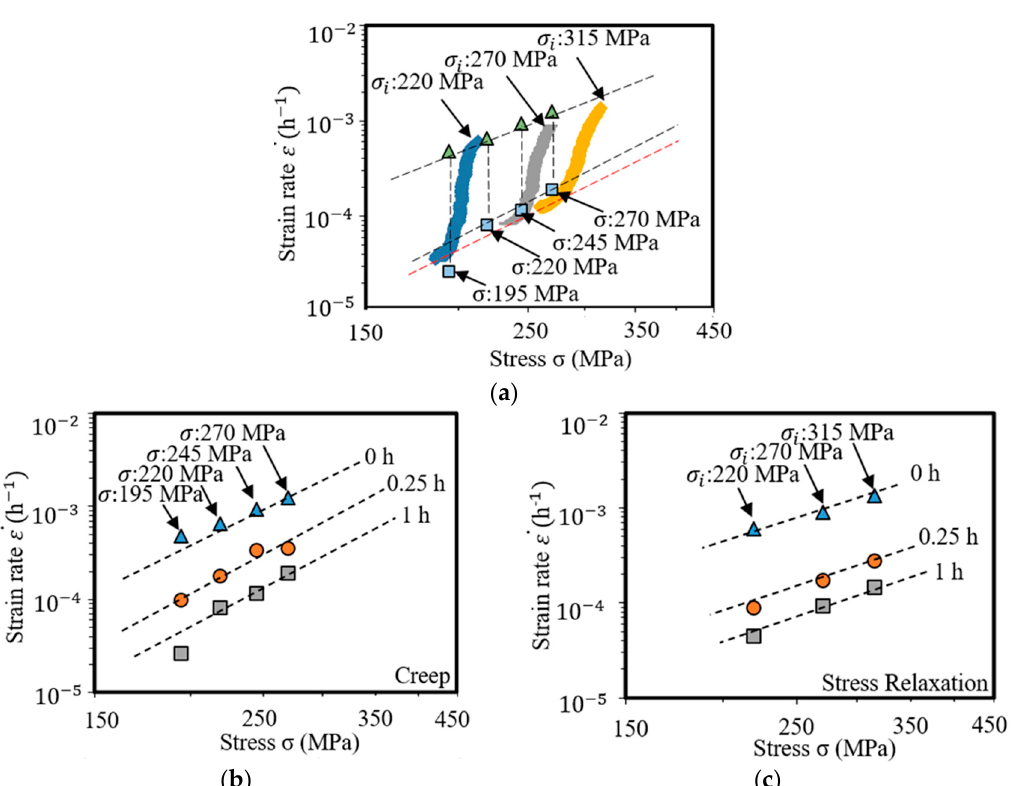
Figure 5. ( a ) Strain rates vs. stress in log scales. Polygons are strain rates from creep tests. Solid lines are strain rates from stress relaxation tests in ageing extracted from Figure 3c, i.e., slope of creep strain under different stresses. ( b ) The initial (0 h), transient (0.25 h), and steady-state (1 h) creep strain rates are obtained from creep under different stresses. ( c ) The initial (0 h), transient (0.25 h), and steady-state (1 h) creep strain rates are obtained from stress relaxation under different initial stresses.